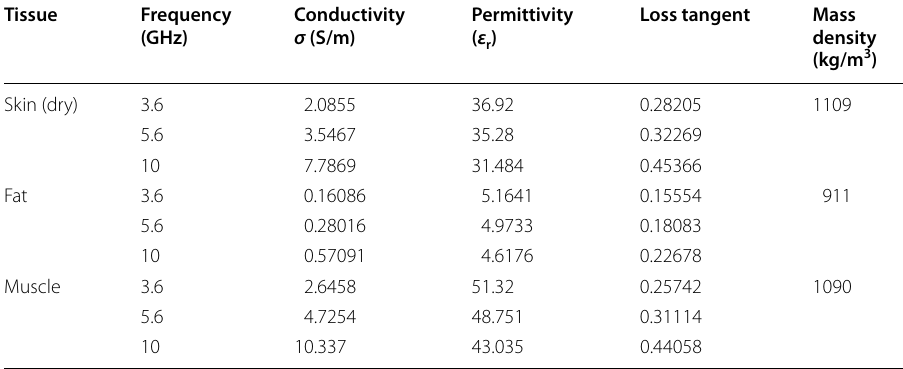
Table 3 Electrical properties of human tissues Tissue Frequency